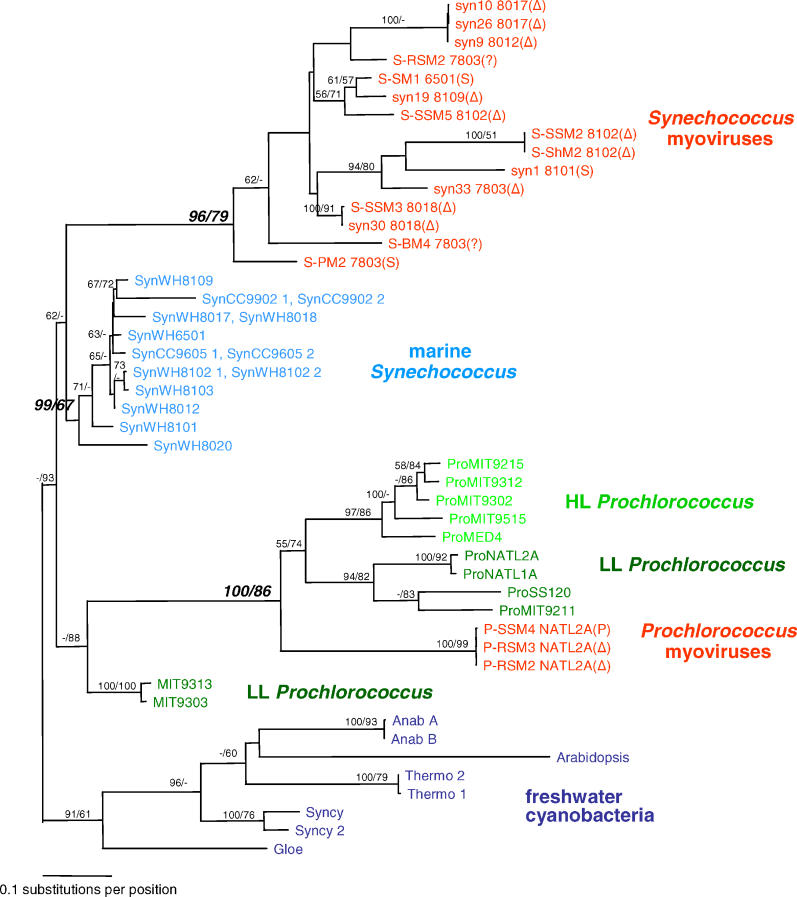
Phylogenetic Tree of
psbD Gene Sequences from Cultured Cyanobacteria and Cyanophages
Details as in
Figure 1. Sequences where intragenic recombination was detected using other methods (e.g., P-SSM1) were not included in these phylogenetic analyses.